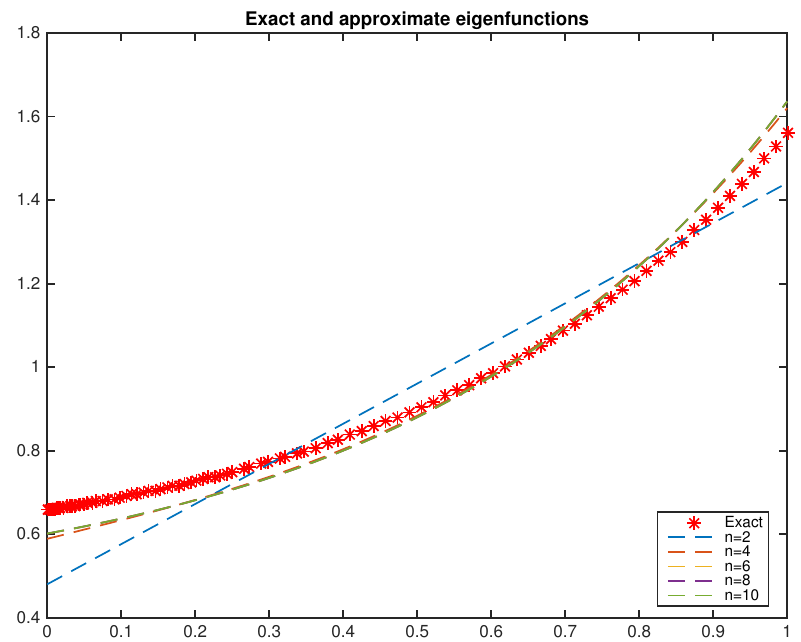
Figure 3. Exact and approximate eigenfunctions for the kernel K ( x , ξ ) = exp ( x + ξ ) + exp ( − x − ξ ) over [ 0,1 ] 2 at various truncation orders.